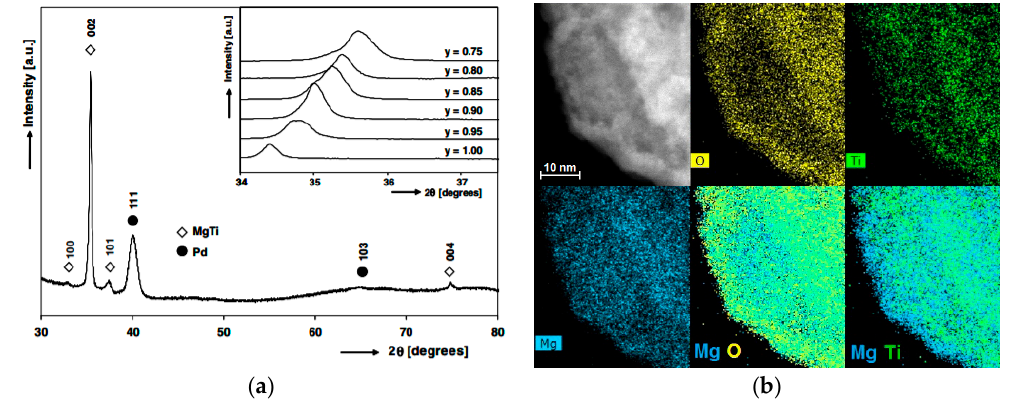
Figure 13. ( a ): XRD profiles of a 200-nm thick Mg 0.80 Ti 0.20 thin film, capped with 10 nm of Pd. Indicated are the reflections and orientations of the different layers. The inset shows the evolution of the (002) reflections of Mg y Ti (1 − y) alloys with y ranging from 0.75 to 1.00. Reprinted with permission from Ref.